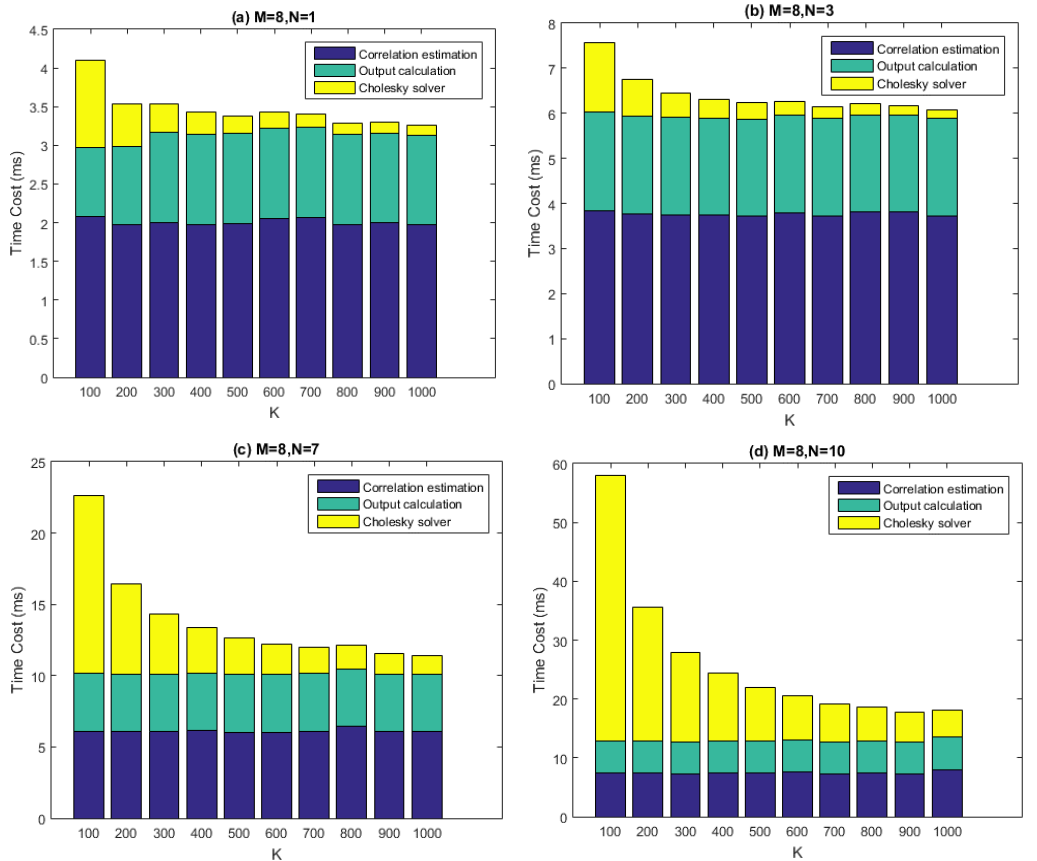
Figure 12. Performance of the batched STAP implementation. M denotes the number of antenna elements and N denotes the filter tap length. The real-time threshold is 50 ms. ( a ) Results of time cost when M is 8 and N is 1; ( b ) Results of time cost when M is 8 and N is 3; ( c ) Results of time cost when M is 8 and N is 7; ( d ) Results of time cost when M is 8 and N is 10.